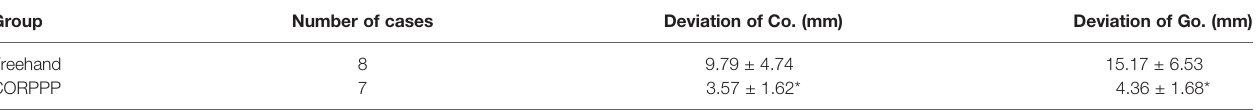
TABLE 3 | Deviation comparison between CORPPP group and freehand group in patients with ramus reconstruction.